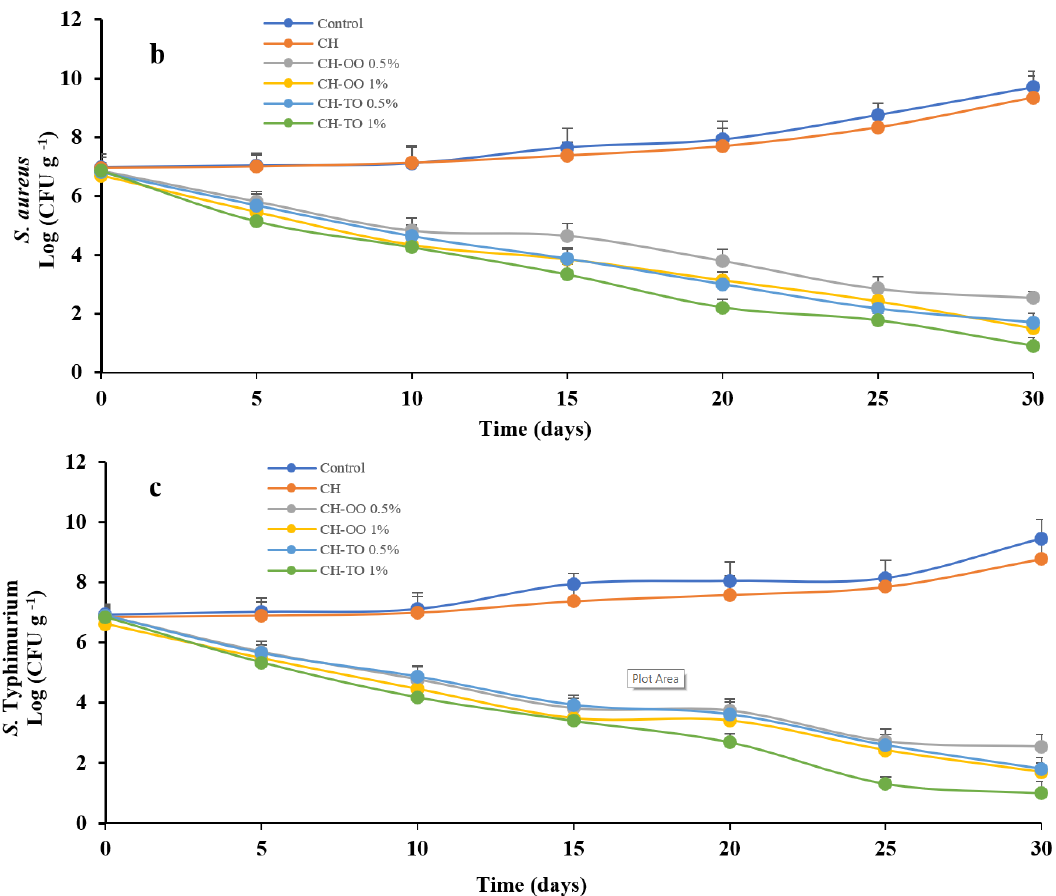
Figure 4. Antimicrobial activity of chitosan (CH) film incorporated oregano (OO) and thyme (TO) essential oils on E. coli O157:H7 ( a ) S. aureus ( b ), and S. Typhimurium ( c ) in the top round of beef during storage time. Error bars indicate standard deviation, (n = 3). Control: without film and oil; CH: chitosan; CH − OO 0.5%: chitosan+ oregano oil 0.5%; CH − OO 1%: chitosan+ oregano oil 1%; CH-TO 0.5%: chitosan+ thyme oil 0.5%; CH − TO 1%: chitosan+ thyme oil 1%.